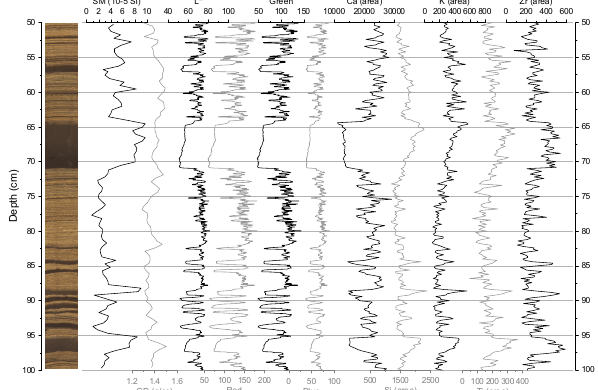
Fig. 2b. Sediment core images, Magnetic Susceptibility (MS) and Gamma Density (GD) measurements, CIE L* and RGB colour data, and main elements from XRF measurements of a 50cm long section from core LL08-1.